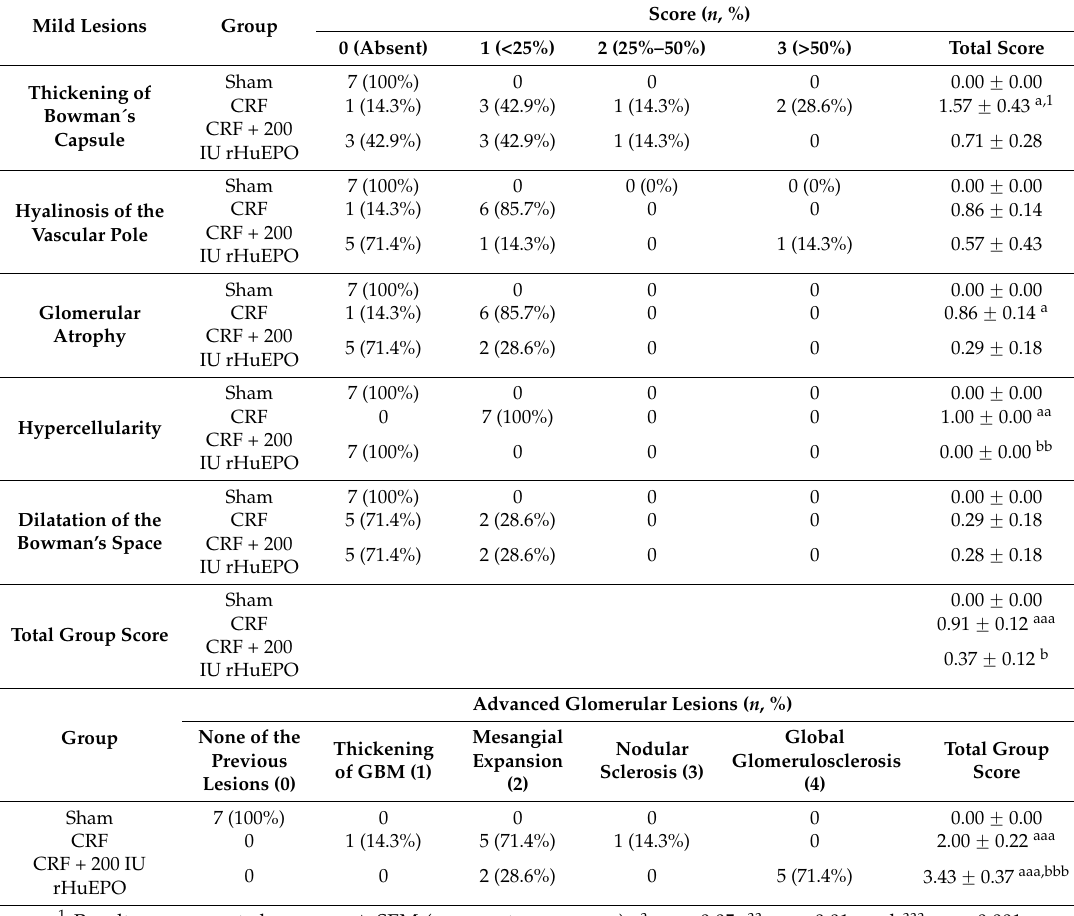
Table 2. Scoring and distribution (%) of mild and advanced glomerular kidneys lesions.